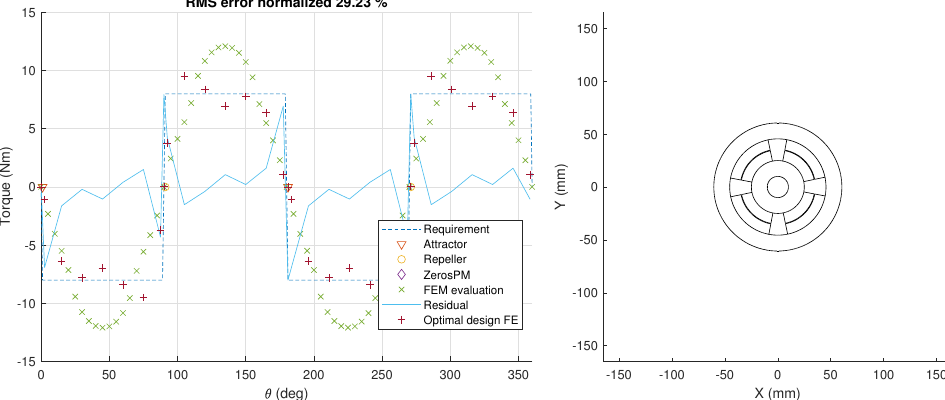
Figure 8. Free shape approach with spline formulation, optimization results for rectangular reference torque. Left —FEM torque characteristic calculation, right —initial magnetic spring geometry.